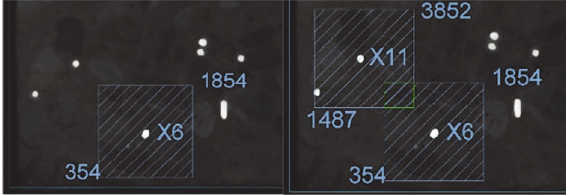
Table 3. Fiber dimensions, calculation of fiber dosage and